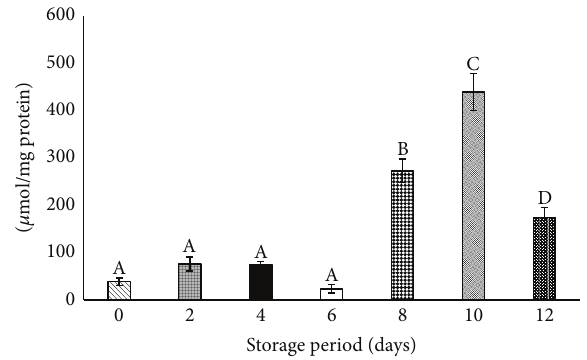
Figure 1: Aggregation in stored platelets. Values are mean ± SE of five animals/group. One-way ANOVA was performed between the groups followed by Tukey-Kramer multiple comparison test, using Graph Pad Prism 6 software, and represented in upper case at 𝑃 < 0.05 . Those not sharing the same letters are significantly different.